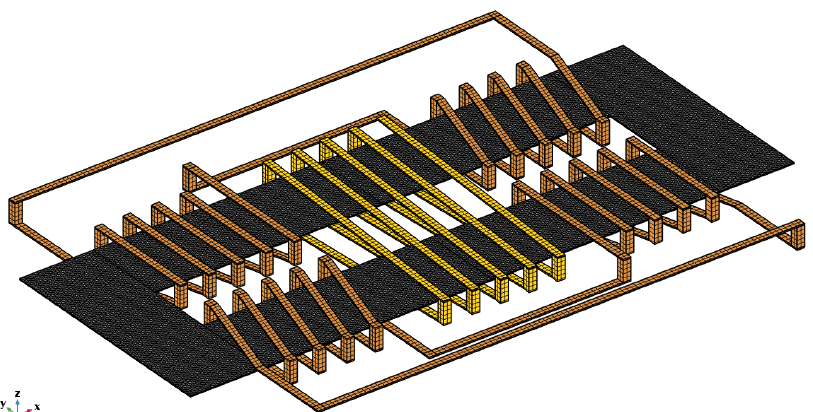
Figure 15. Meshed model implemented in Comsol ® reproducing the MSFS sensor described in [25] Copyright 2022 Elsevier; in gray is the ferromagnetic core, the excitation coils are in orange, and the detection coil is in